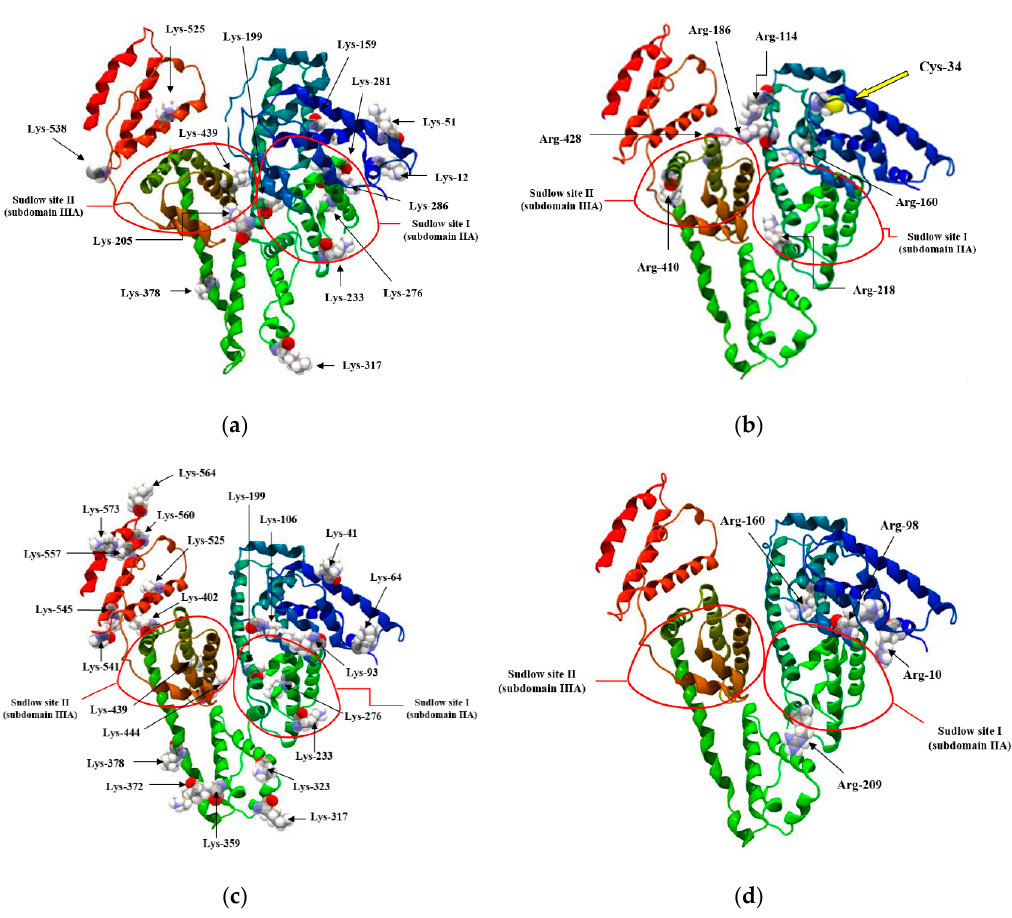
Figure 1. Human serum albumin drug binding sites (i.e., Sudlow’s site I and II) with the location of main ( a , c ) lysine (Lys) and ( b , d ) arginine (Arg) residues involved in ( a , b ) in vivo [16] and ( c , d ) in vitro [17] glycation.